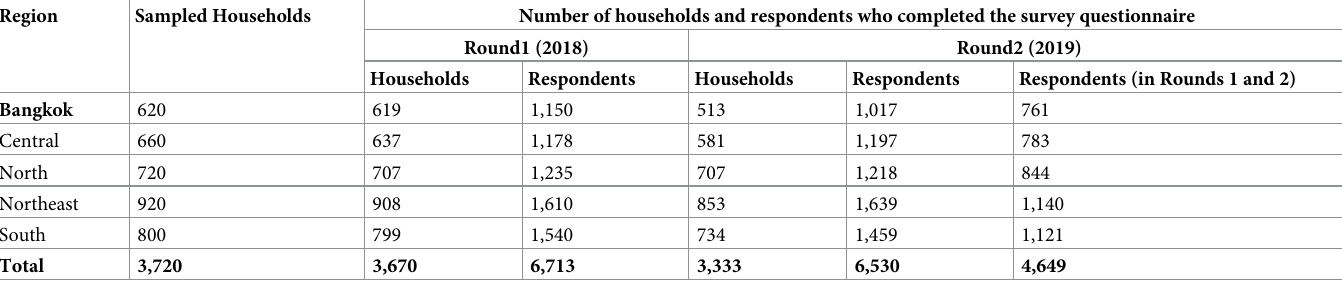
Table 1. Number of sampled households and respondents (age 15 years or older) of the survey in Rounds1 and 2. Region Sampled Households Number of households and respondents who completed the survey questionnaire Round1 (2018)